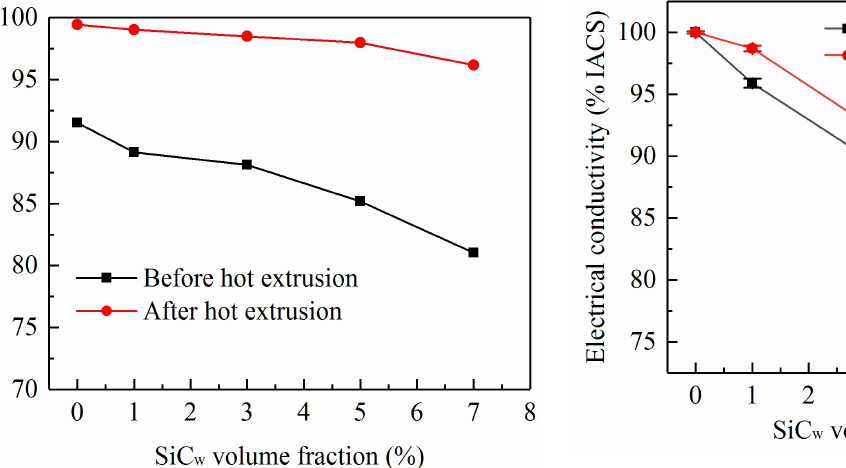
Figure 5: The electrical conductivity of cross and longitudinal sec- tions of SiC w /Cu composites with different SiC whiskers content